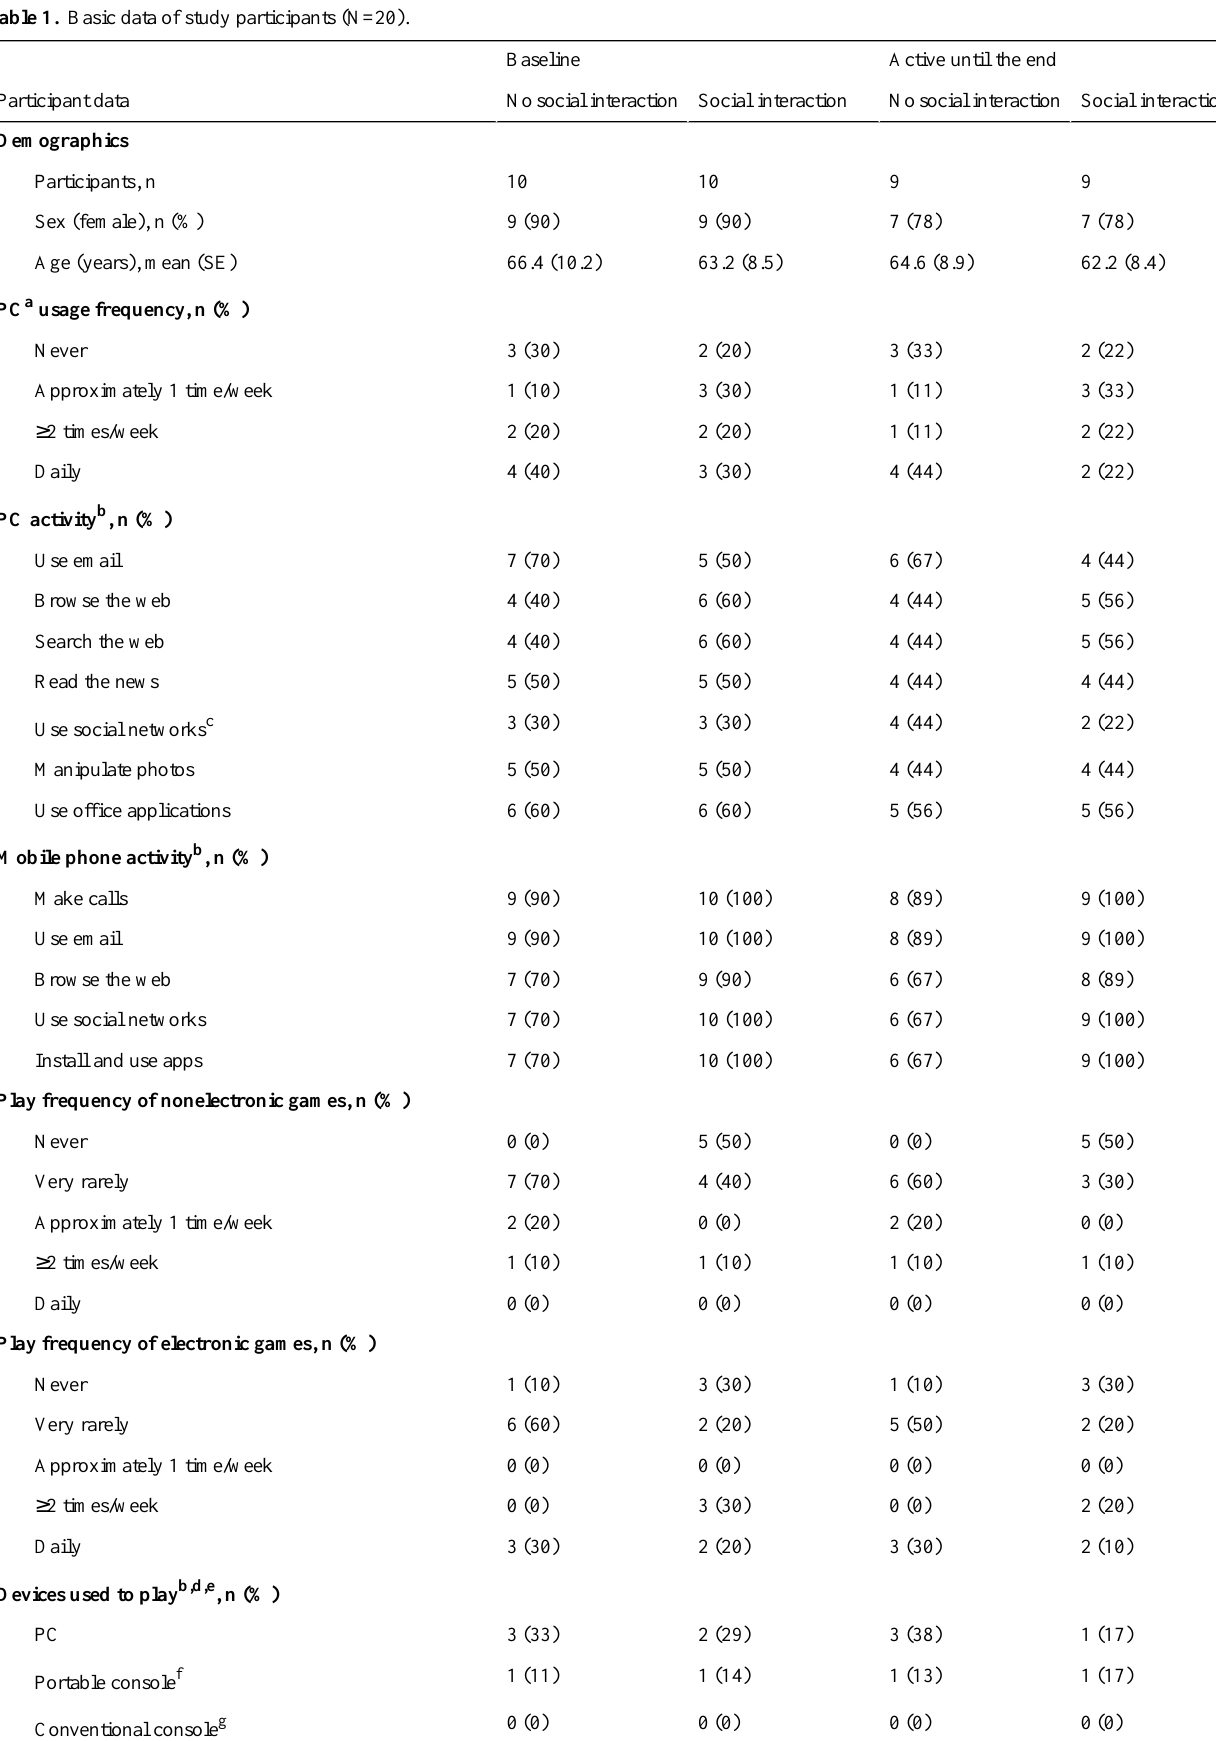
Table 1. Basic data of study participants